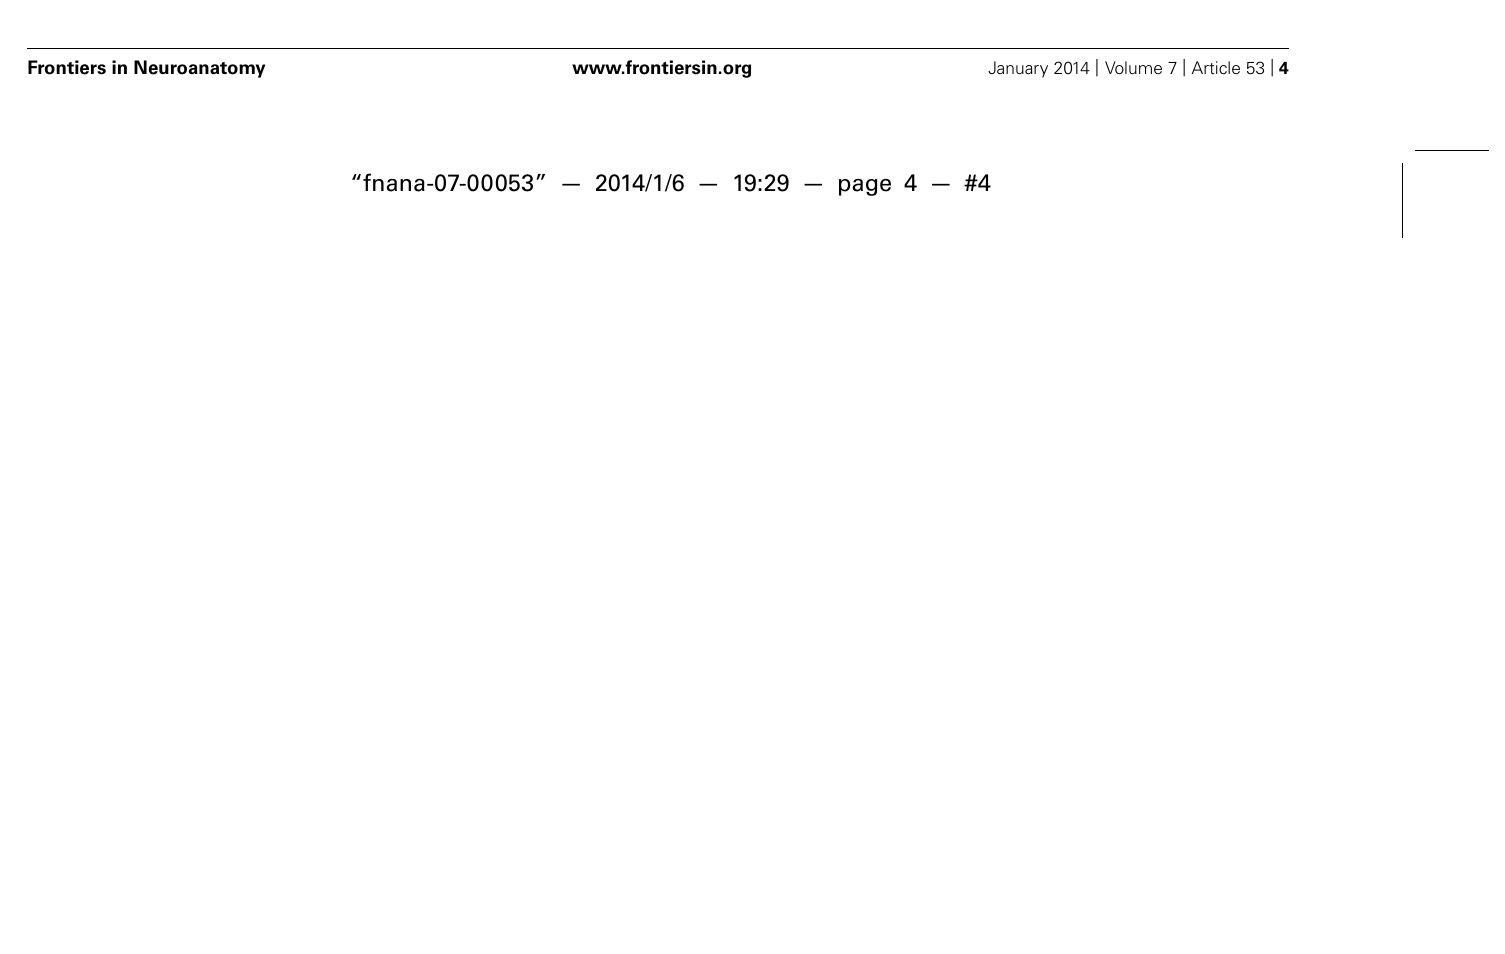
( Figure 5B ). While a minority of WFA-labeled PNs surround GAD-negative cells, this still corresponds to about 30% of the total WFA-labeled PN population in